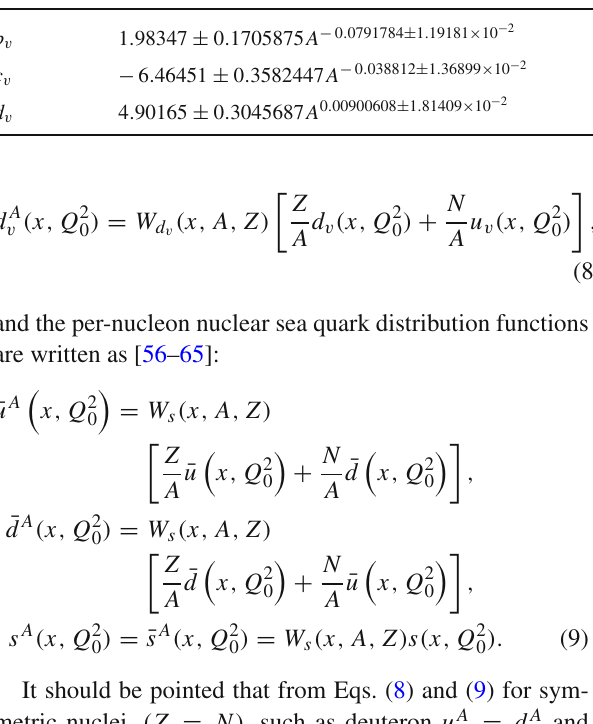
Table 1 The input parameters of valence and sea weight functions, Eqs. (4) and (5), as the functions of A at Q 2 [56] a